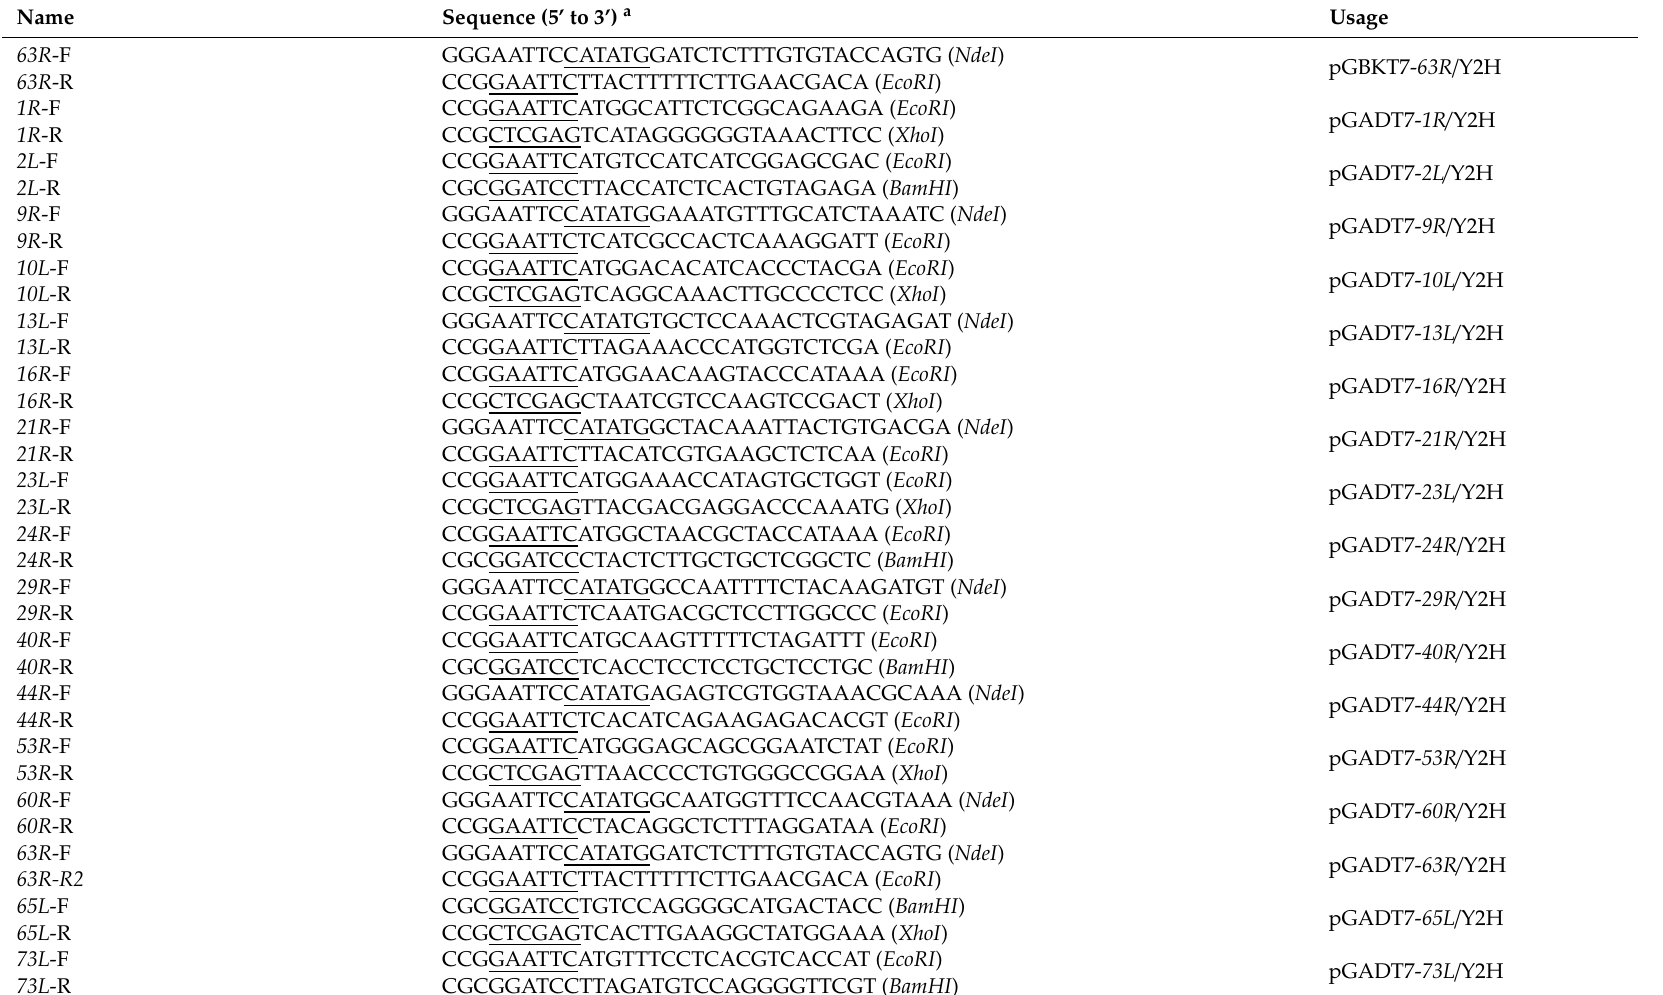
Table 1. Primers used in this